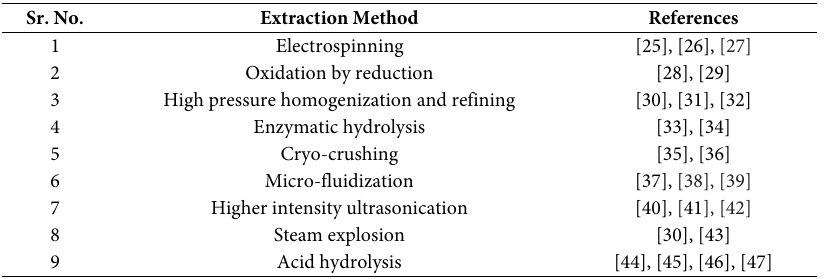
Table 1. Nanocellulose Extraction